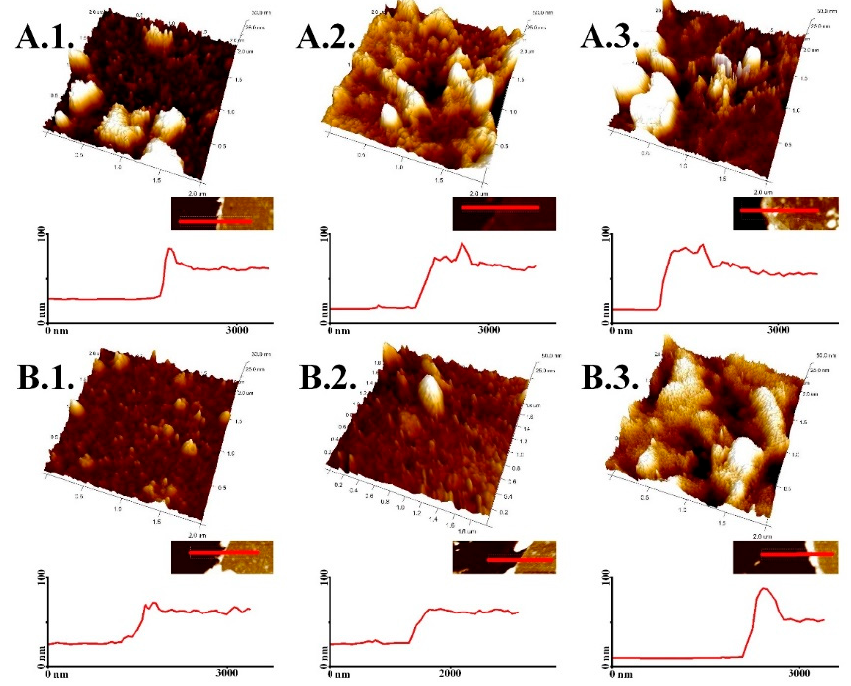
Figure 6. The topography and cross sections of CAm&AAm PEMs on silicon for negatively ( A.1 – A.3 panel) and positively charged topmost layer ( B.1 – B.3 panel) for dry (column 1) and swollen films after 30 min incubation in PBS (column 2) or 1 M NaCl solution (column 3).